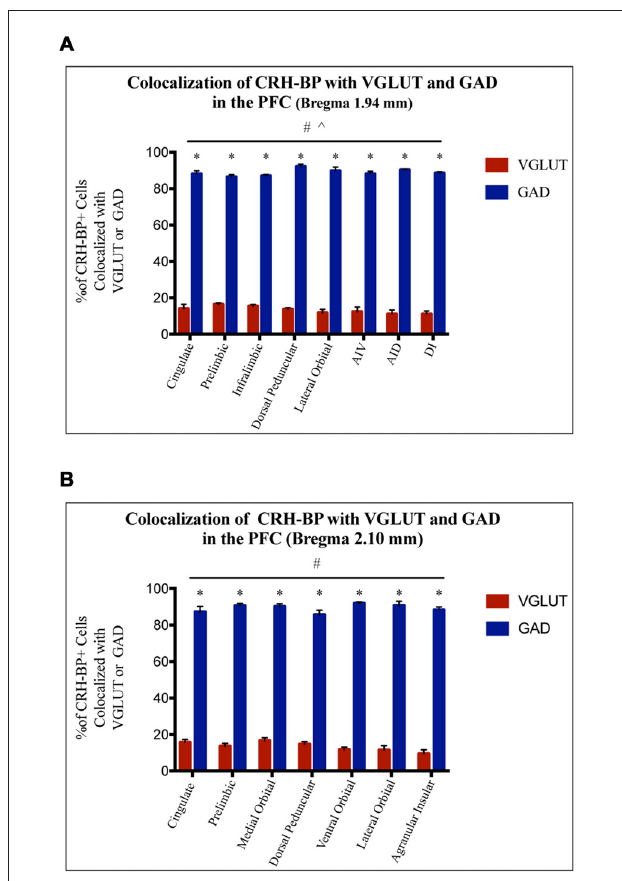
FIGURE 2 | CRH-BP mRNA colocalizes predominantly with GAD in the PFC. Quantification of CRH-BP mRNA colocalization with GAD and VGLUT in the caudal PFC ( A , Bregma coordinate 1.94 mm) and a more rostral region of the PFC ( B , Bregma coordinate 2.10 mm). Data represent the percentage of CRH-BP-positive cells colocalized with VGLUT or GAD mRNA. The colocalization between CRH-BP and GAD was significantly higher than the colocalization between CRH-BP and VGLUT at both Bregma coordinates (A,B) , as revealed by a significant main effect of cell type ( # p < 0.0001). Post hoc analyses showed that the degree of colocalization was significantly higher for GAD compared to VGLUT in all subregions of the PFC at both Bregma coordinates ( A,B ; ∗ p < 0.0001). ˆ p < 0.05 interaction. Data represent the mean ± SEM. AIV, agranular insular ventral; AID, agranular insular dorsal; DI, dysgranular